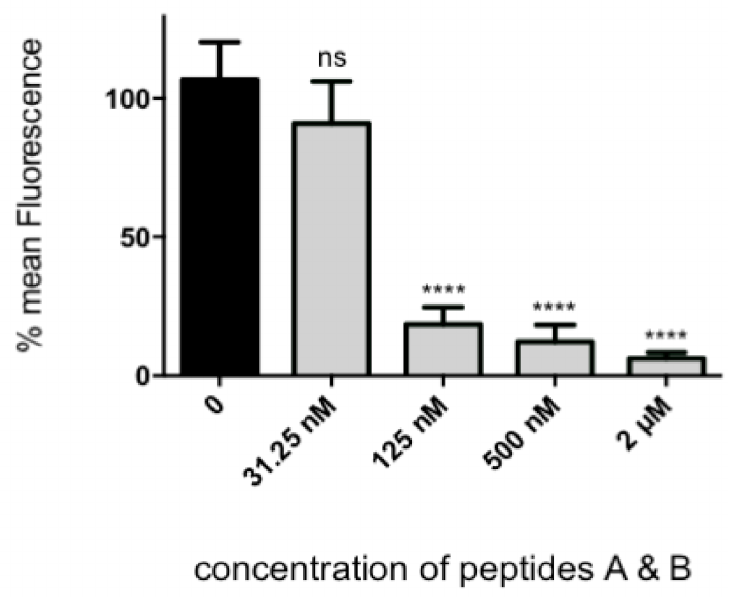
Figure 5. Equimolar quantities of peptide A and B vs. virus competition assay with HEp-2 cells. Note that 2 µ M of peptides A and B are sufficient to reduce virus replication by 94%. p < 0.0001, average of 6 experiments. Bonferroni’s multiple comparison test. ns, not significant; ****, p <